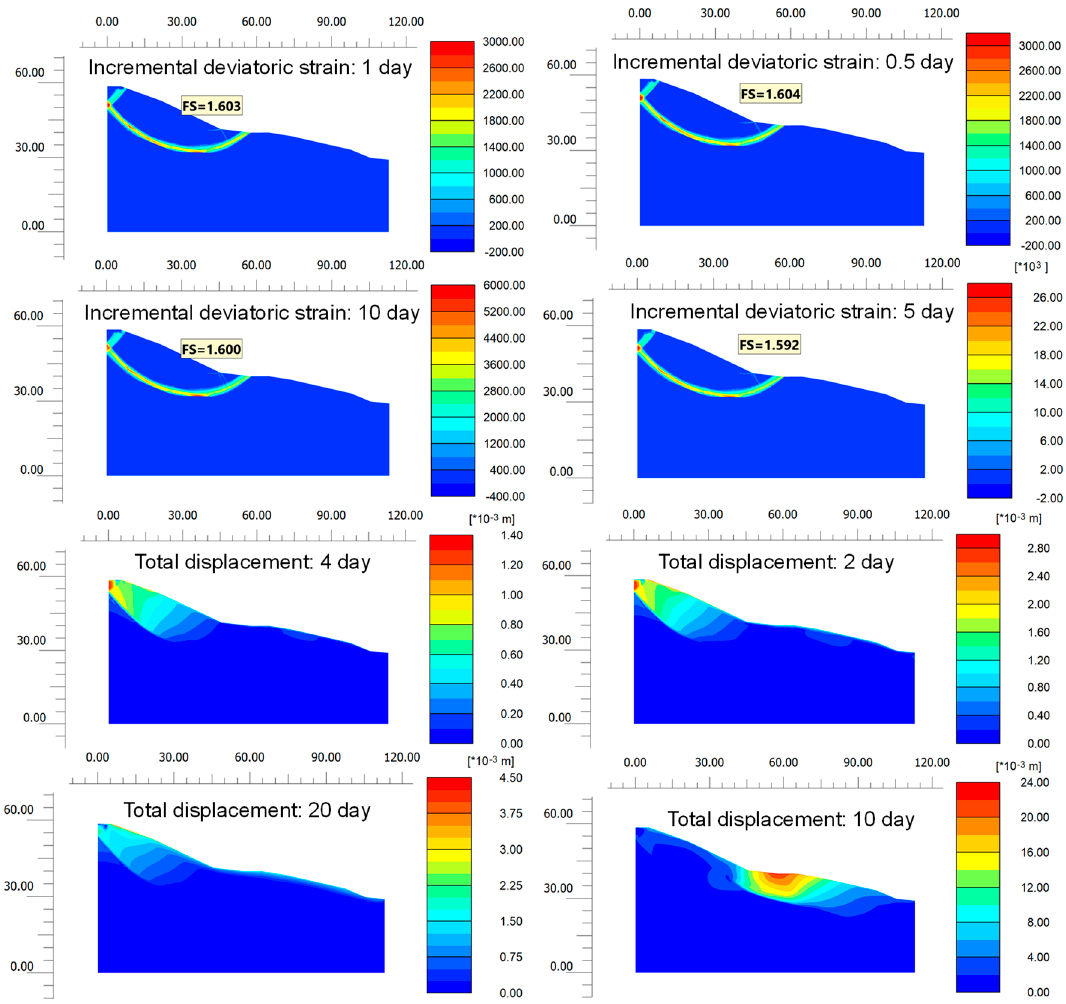
Figure 10. Incremental deviatoric strain during FS calculation and total displacement during rainfall for the case without vegetation reinforcement: left with a rainfall intensity of 10 mm/day and right with a rainfall intensity of 50